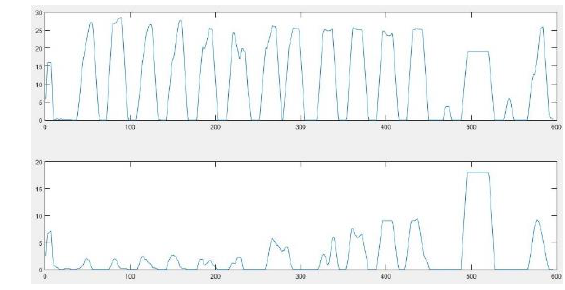
Figure 6.a. The vertical histogram for each floor Figure 6.b. The smoothed vertical histogram for each floor